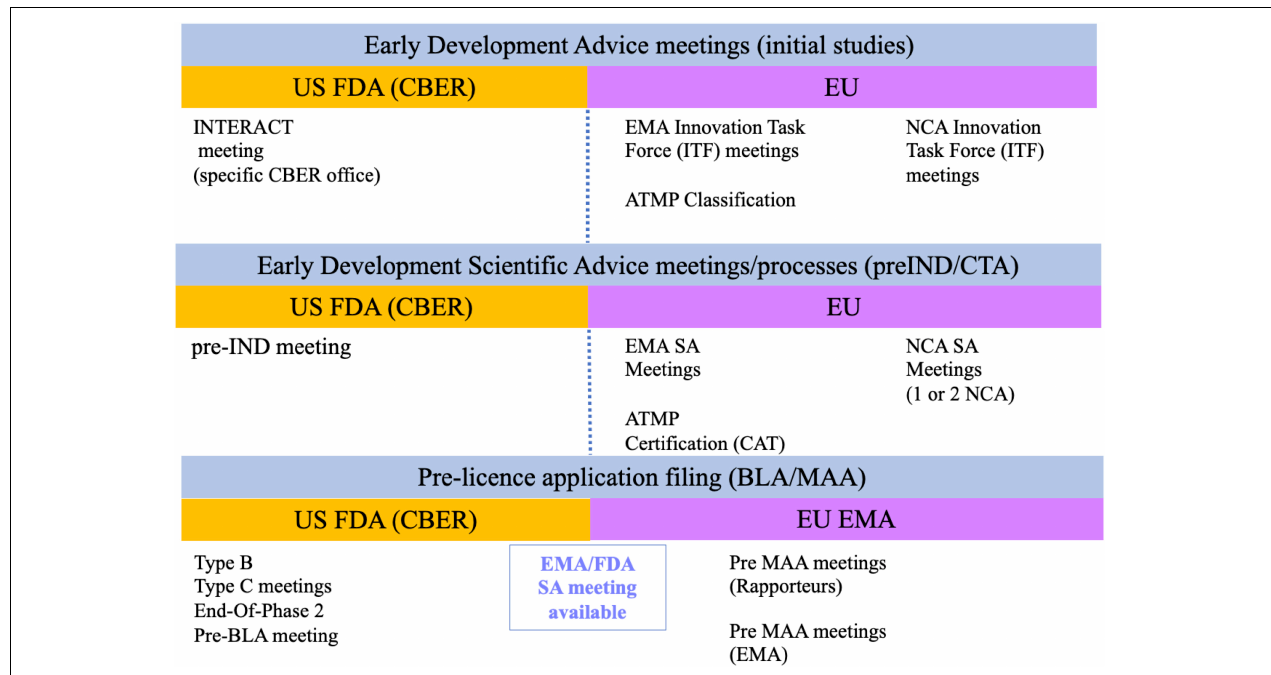
FIGURE 1 | Current formal regulatory meetings with US and EU regulatory